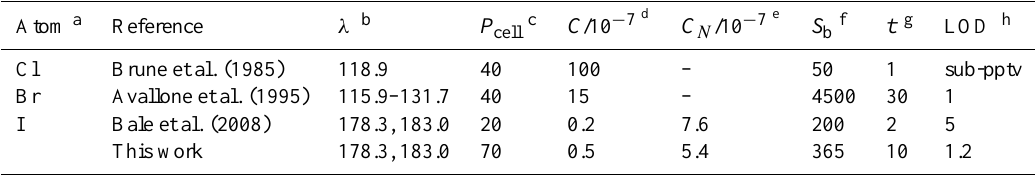
Table 1. Comparison of characteristics and performance of a selection of RF instruments reported in the literature. Atom a